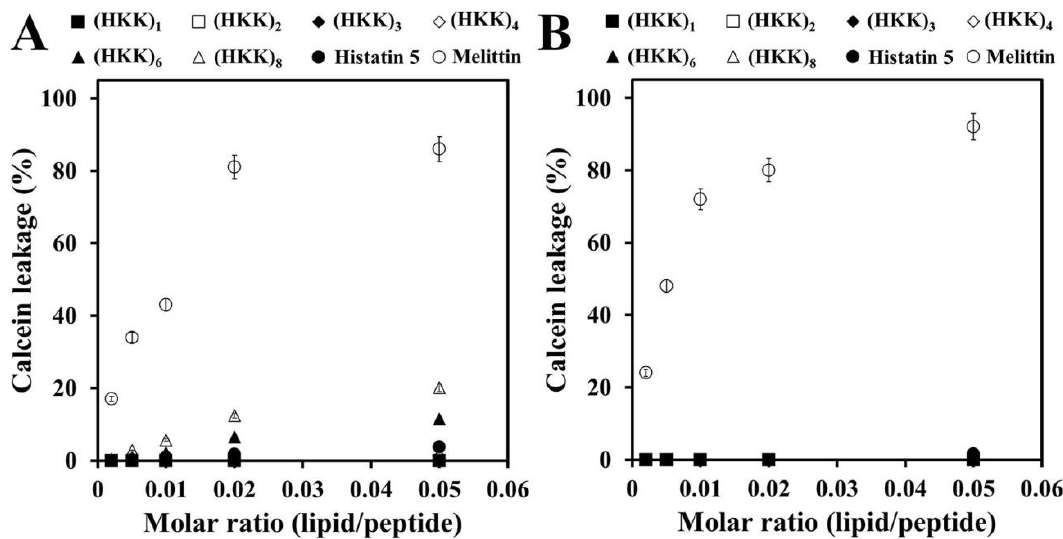
Figure 3. Calcein leakage from calcein-entrapped liposomes was measured by adding peptides at the indicated molar ratios (lipid/peptide). ( A ) PC/PE/PI/ergosterol (5:4:1:2, w / w / w / w ); ( B ) PC/Ch/SM (1:1:1, w / w / w